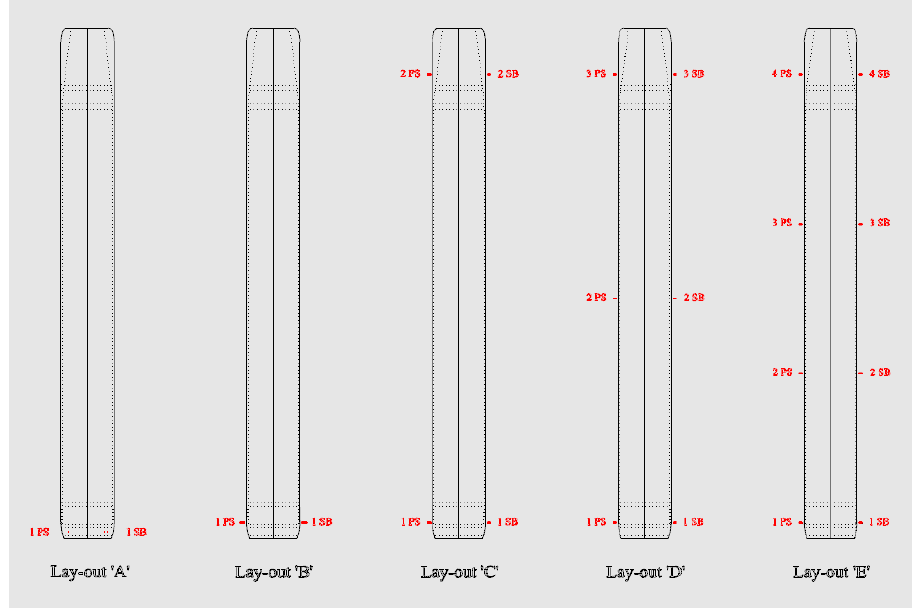
Figure 3. Different hull/propulsion layouts examined by CFD analyses. Source: Authors. Figure 3. Di ff erent hull / propulsion layouts examined by CFD analyses. Source: Authors.